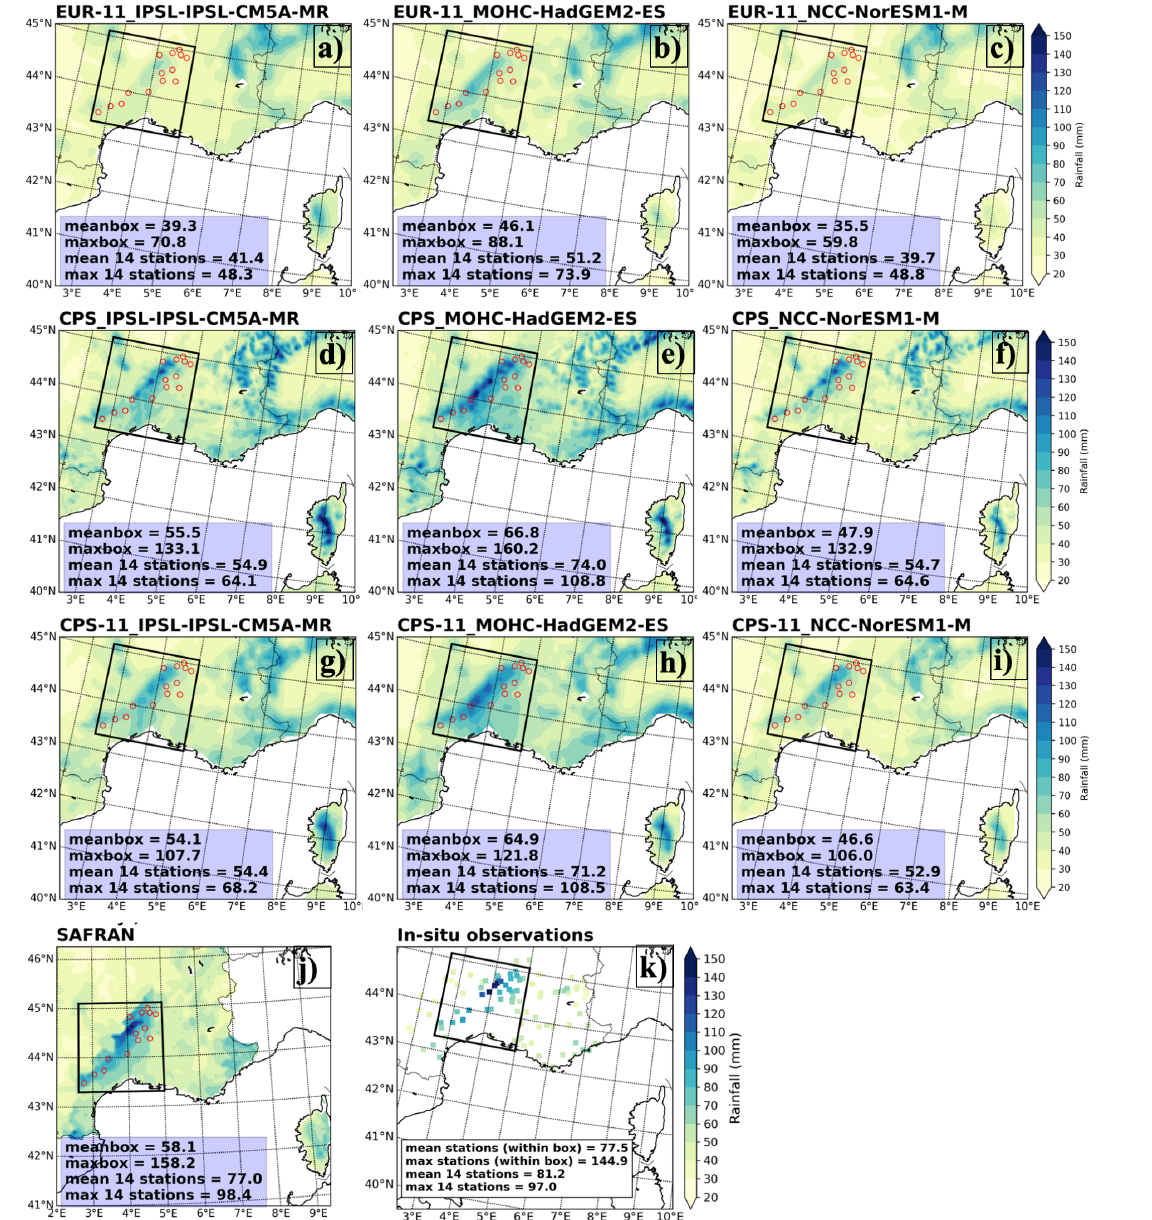
Figure 2. The autumn maximum daily rainfall (Rx1day) from EUR-11 (a–c) simulations (1951–1980), CPS (d–f) simulations (1951–1980), CPS-11 (g–i) , SAFRAN (j) (1961–1990), and in situ observations (k) (1961–1990); the red empty circles inside the Cévennes box from panels (a) to (j) denote 14 stations used in Vautard et al.